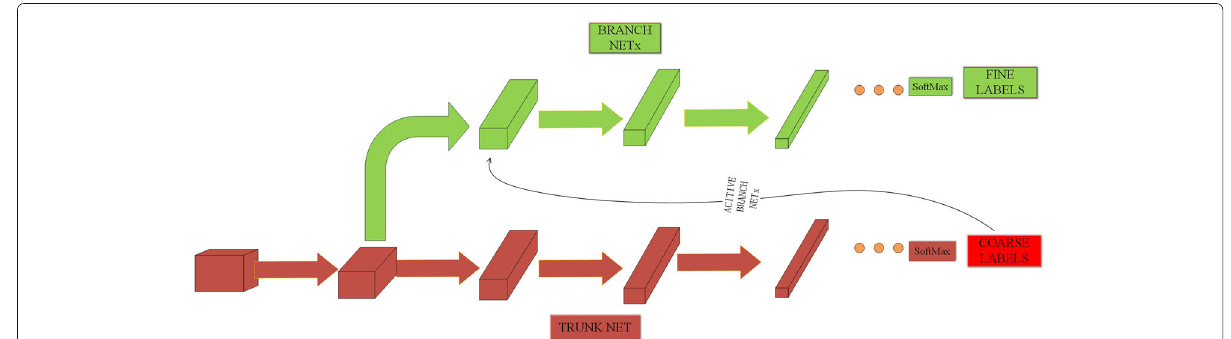
Fig. 2 Processing flow chart of the Tree-CNN. First, the Tree-CNN obtains the image’s coarse category by the Trunk-Net. Second, according to the coarse category, the Tree-CNN selects a corresponding Branch-Net which obtains special feature map of the image and the fine category